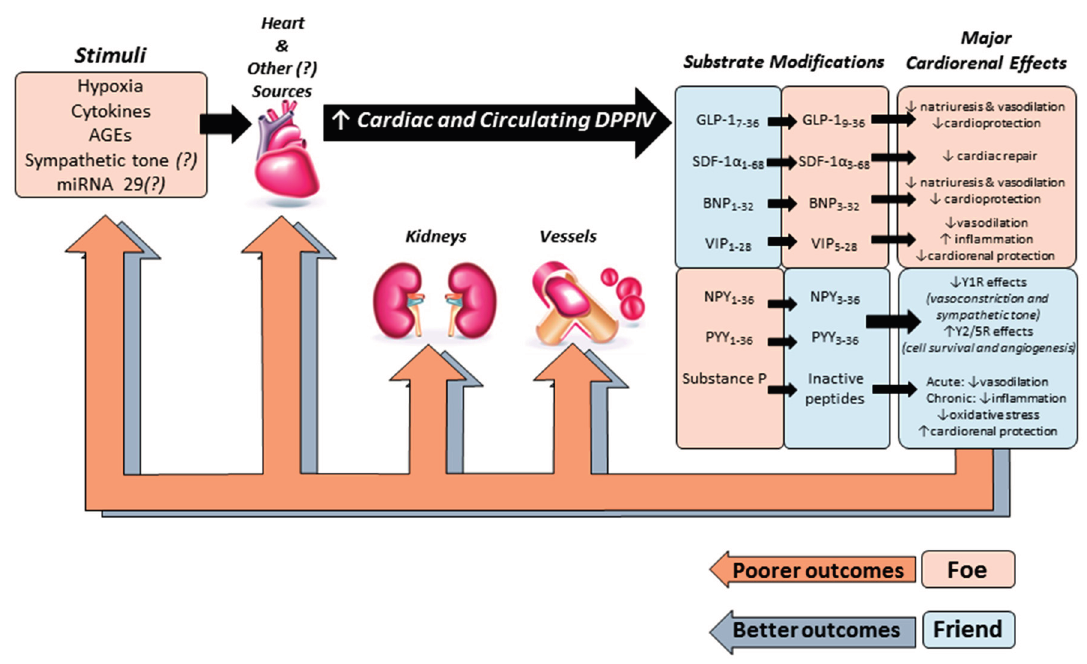
Figure 1. Schematic model depicting the possible role of DPPIV in the pathophysiology of HF. Several stimuli may increase the activity and abundance of both soluble and cardiac DPPIV in HF during the acute and/or chronic stages of this syndrome. High DPPIV activity may reduce the biological activity of peptides with cardio-, vaso- and renoprotective actions including glucagon-like peptide-1 (GLP-1), brain natriuretic peptide (BNP), and stromal cell-derived factor-1 α (SDF-1 α ) leading to poorer cardiovascular outcomes. On the other hand, the protease activity of DPPIV can be beneficial for the cardiovascular system by cleaving neuropeptide Y (NPY) and peptide YY